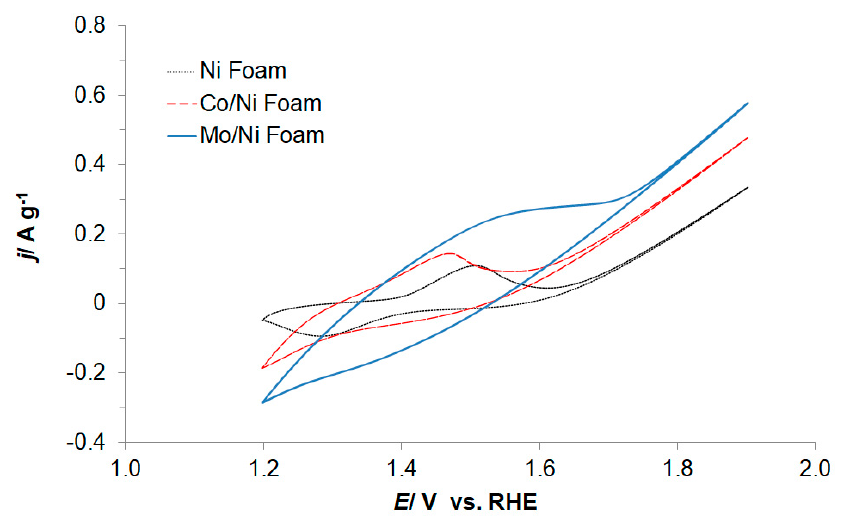
Figure 2. Cyclic voltammogram curves of oxidized, pure Ni, Co- and Mo-activated Ni foam electrodes, in contact with 0.1 M NaOH medium (at 20 °C), carried-out at a scan-rate of 50 mV s − 1 for the potential span 1.2–1.9 V vs. RHE.